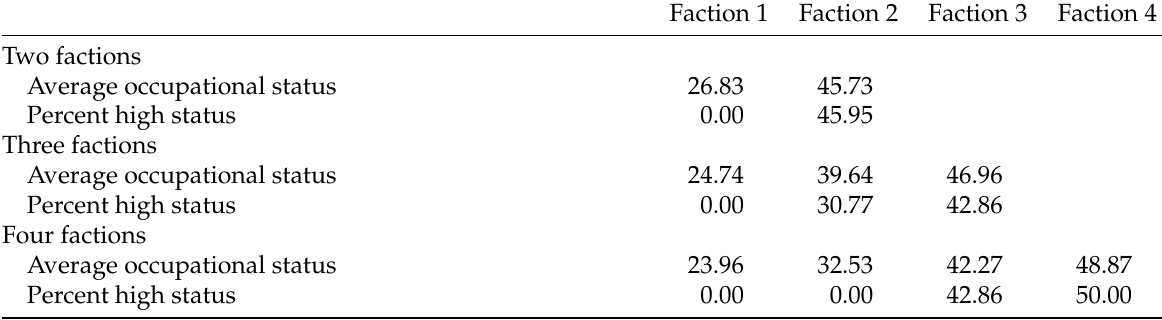
Table 6: Average occupational status for network factions,